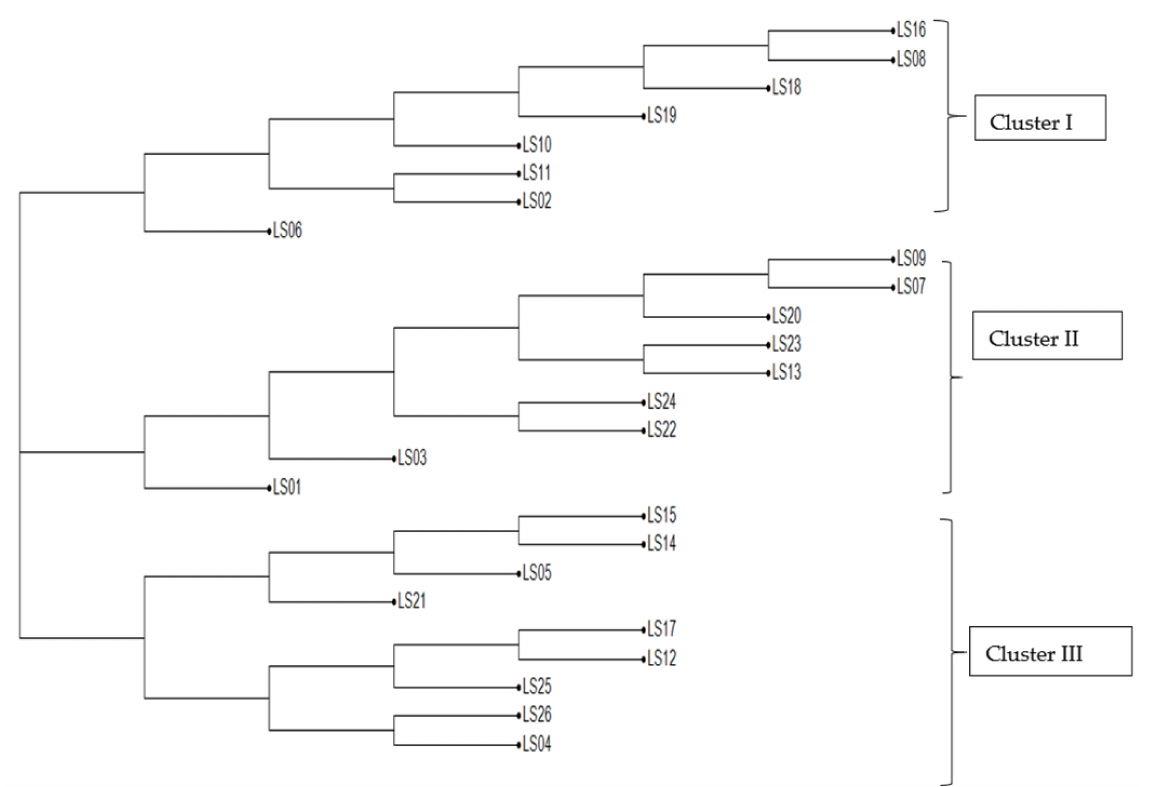
Figure 3. Dendrogram showing genetic relationships among 26 okra accessions assessed via 9 poly- morphic SSR markers.